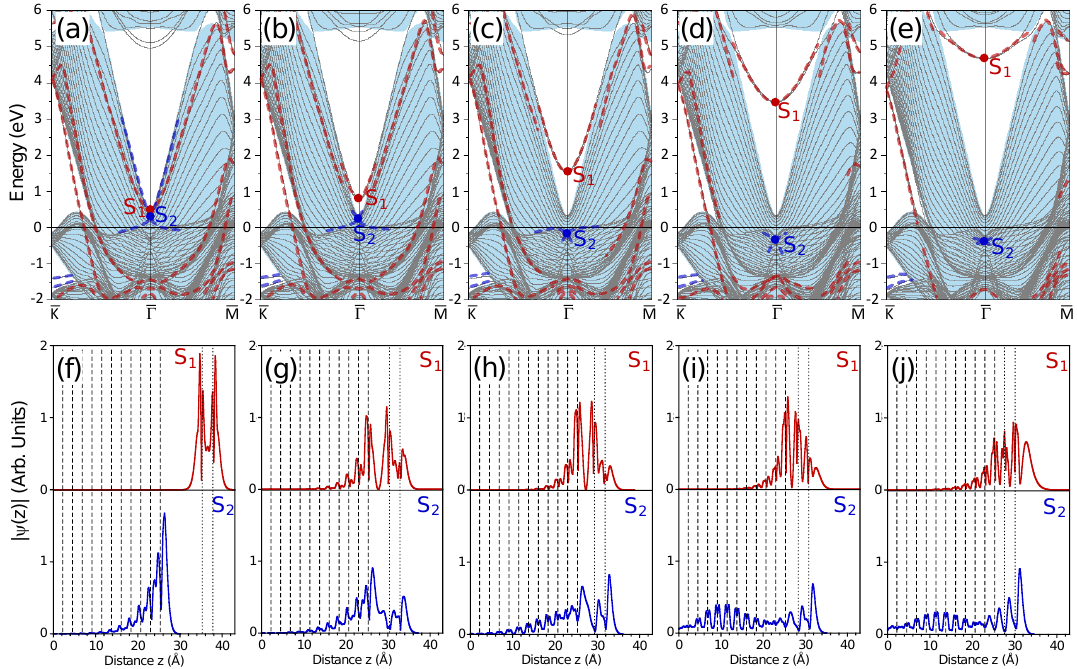
Figure 2. Electronic structure of the 2 ML Au/Pt(111) surface at ( a ) 10 Å, ( b ) 5 Å, ( c ) 4 Å, ( d ) 3 Å, and ( e ) the equilibrium distance between the top Pt and closest Au atomic layers. The surface states discussed in the text are marked as S 1 and S 2 . Panels ( f – j ) present respectively the in-plane averaged charge density distributions of the S 1 (red) and S 2 (blue) surface states. In ( f – j ), vertical dashed (dotted) lines show the positions of the Pt (Au) atomic layers. The central atomic layer of the 23 ML Pt slab is placed at